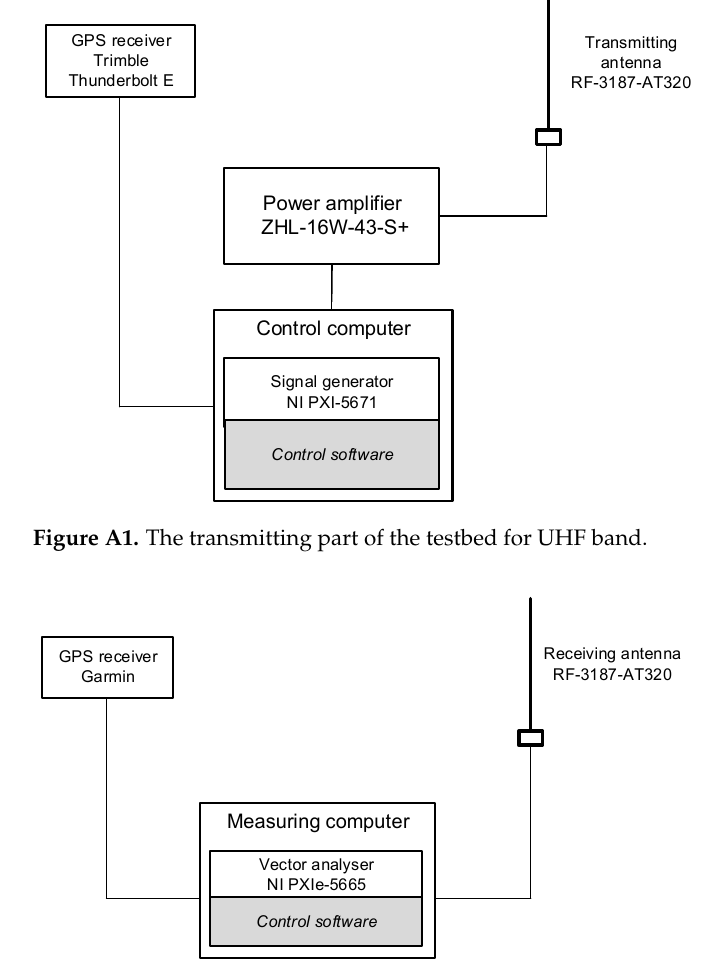
Figure A2. The receiving part of the testbed for UHF band.